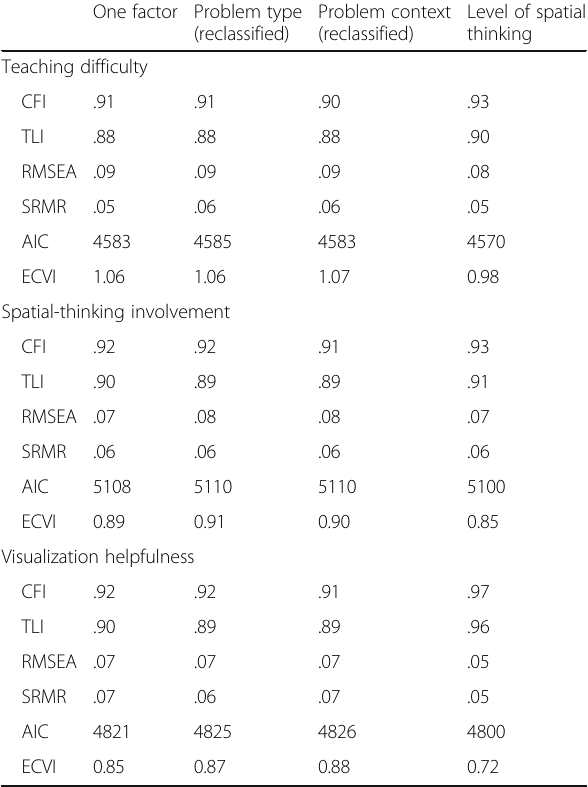
Table 6 Goodness of fit, badness of fit, and fit indices for each structural equation model One factor Problem type Problem context Level of spatial (reclassified) (reclassified) thinking